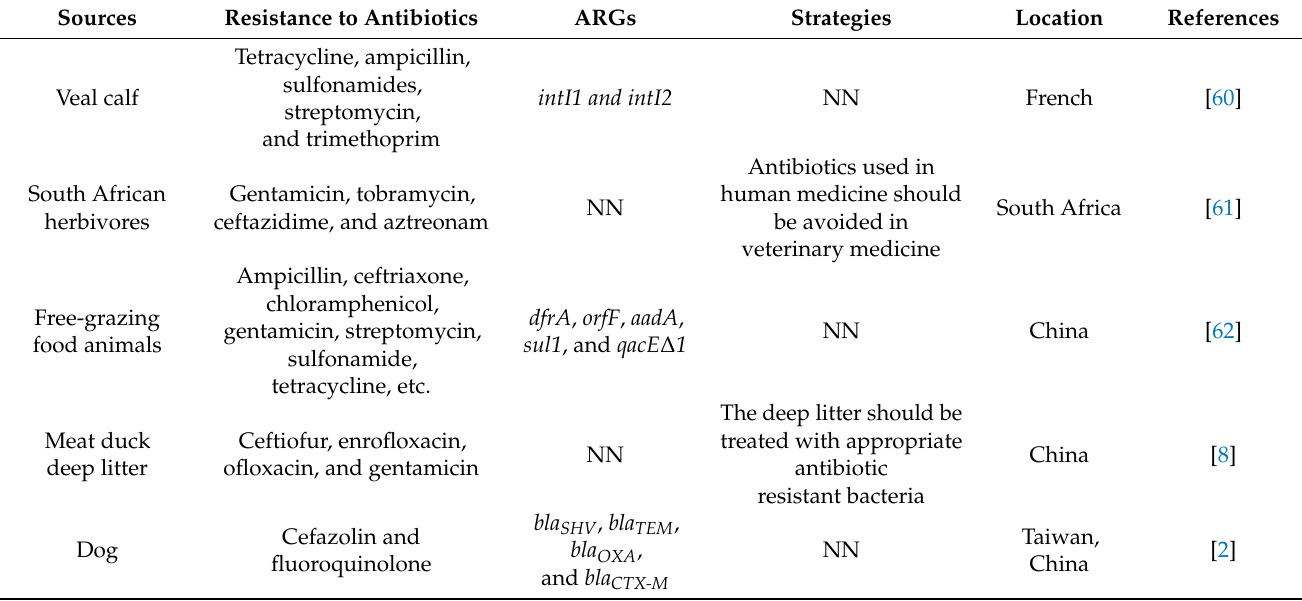
Table 2. AR E. coli and its ARGs in animal waste